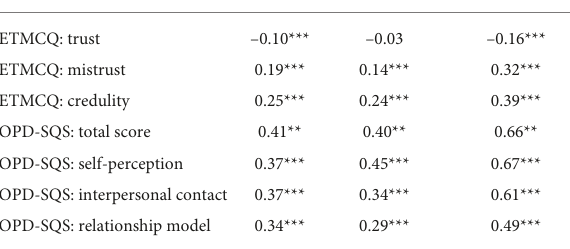
TABLE 3 Correlations between the ETMCQ, ACE, OPD-SQS, ITQ-PTSD, and ITQ-cPTSD